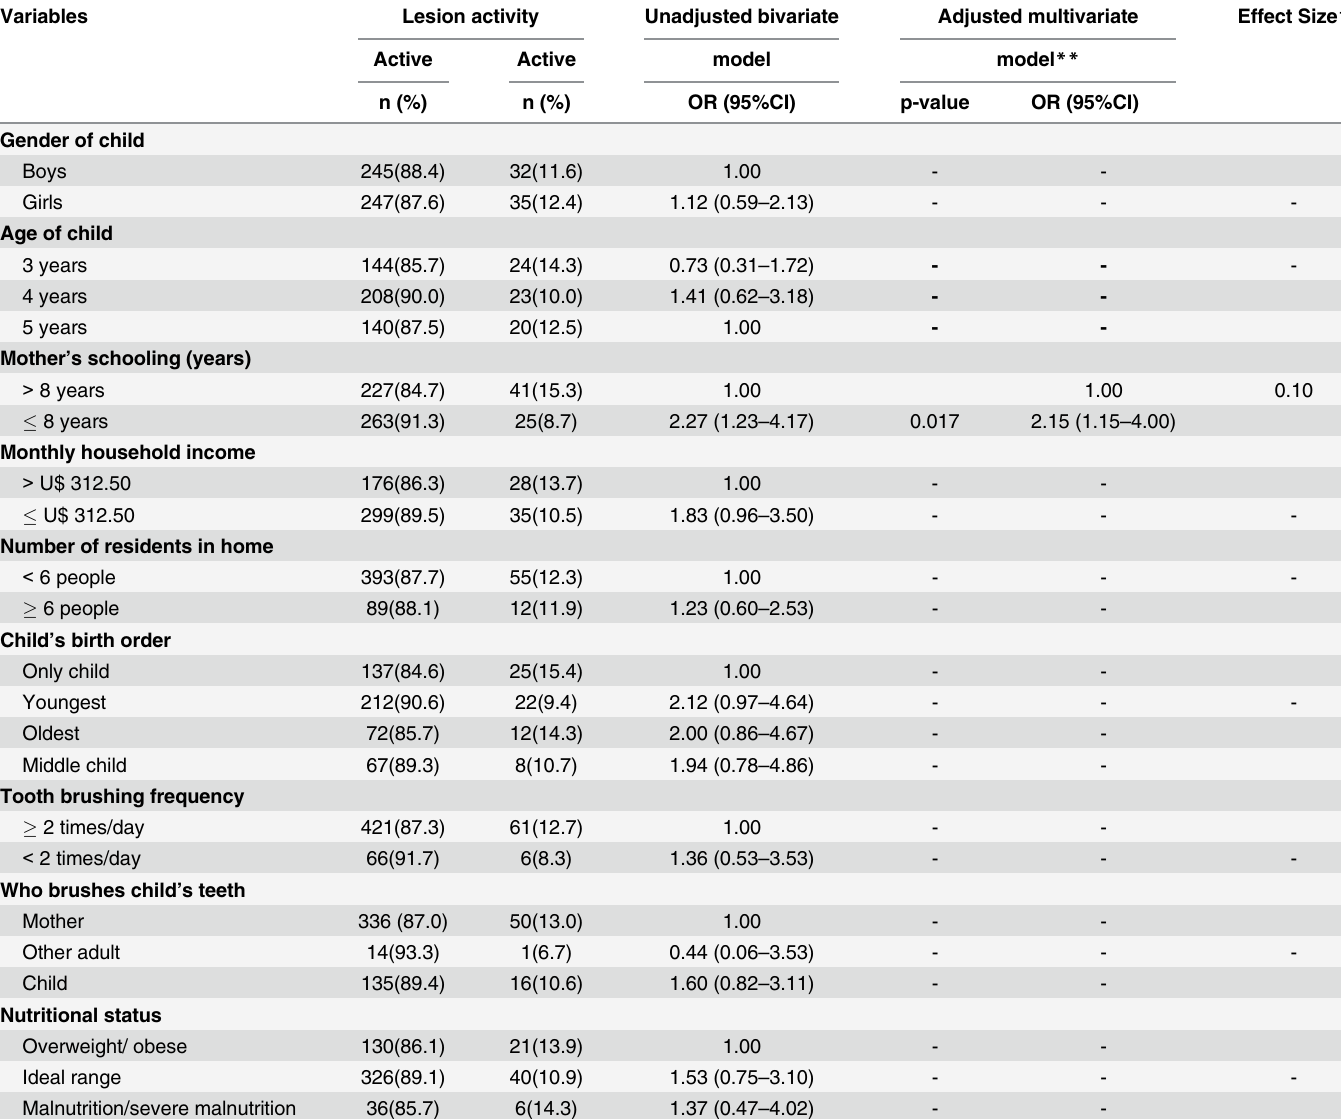
Table 3. Logistic regression model considering design effect (unadjusted and adjusted odds ratio) for lesion activity and independent variables among children aged 3 to 5 years (OR, 95% CI).